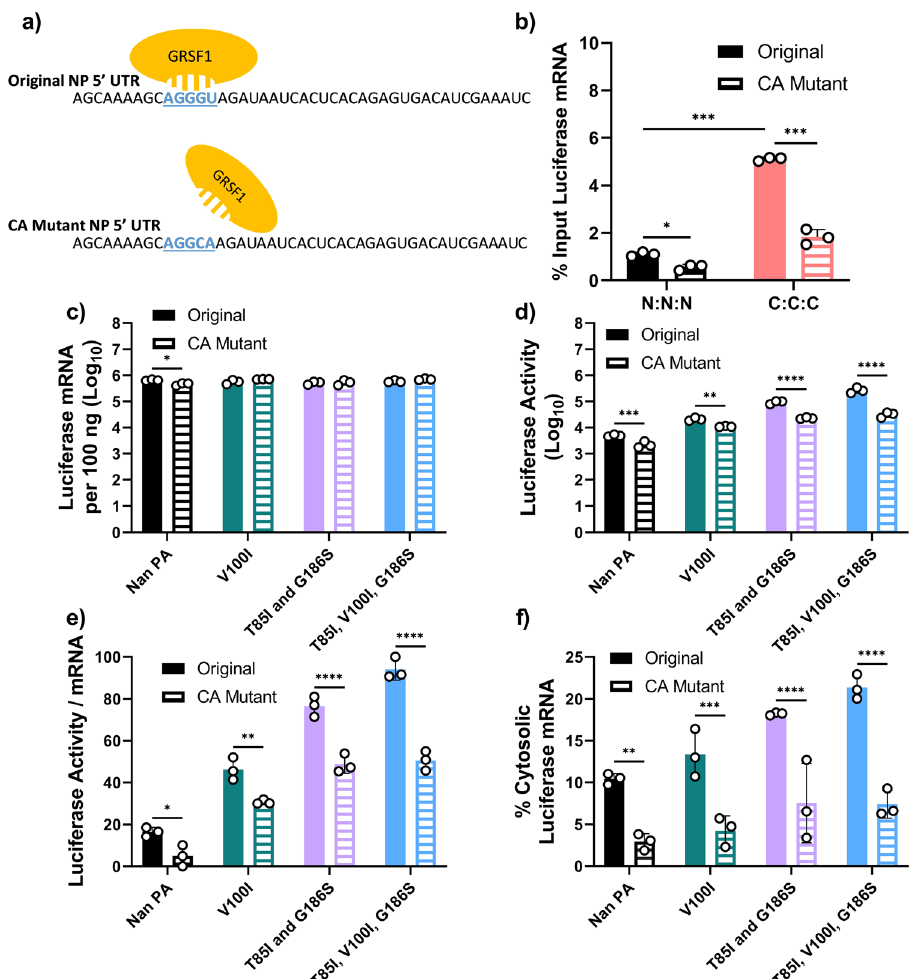
Fig. 6 GRSF1 binding regulates cytosolic accumulation and translation ef fi ciency. a A model diagram showing the interaction of GRSF1 with the 10 AGGGU 14 binding site in the 5' UTR of NP luciferase mRNA. b 293 T cells were transfected with Cal NP and Nan or Cal vRdRp components along with the original pPolI-NP-luc or pPolI-NP-luc CA mutant. Anti-GRSF1 rabbit antibody was used for immunoprecipitation (IP) from whole cell lysates and RNA was extracted from the eluted material. Luciferase mRNAs before and after IP were quantitated by qRT-PCR and percentages of mRNA recovered after IP are shown. c , d 293 T cells were transfected with Cal NP, PB1, PB2, and either Nan PA or Nan PA mutants together with the original pPolI-NP-luc or the pPolI- NP-luc CA mutant c Luciferase mRNA was quantitated by qRT-PCR. d Luciferase activity was determined by the Dual-Luciferase Assay Reporter system. e Ratio of luciferase activity per mRNA, transformed to a normal distribution. f Percentages of cytosolic luciferase mRNA for both templates. Error bars show the means plus/minus standard deviations ( n = 3 biological replicates). Two-Way ANOVA followed by Tukey ’ s multiple comparison test (* P < 0.05, ** P < 0.01, *** P <